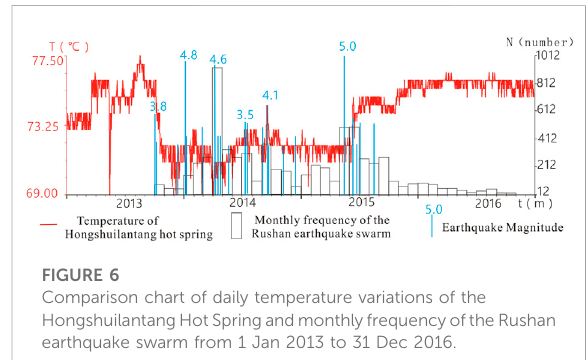
FIGURE 6 Comparison chart of daily temperature variations of the HongshuilantangHotSpringandmonthlyfrequencyoftheRushan earthquake swarm from 1 Jan 2013 to 31 Dec